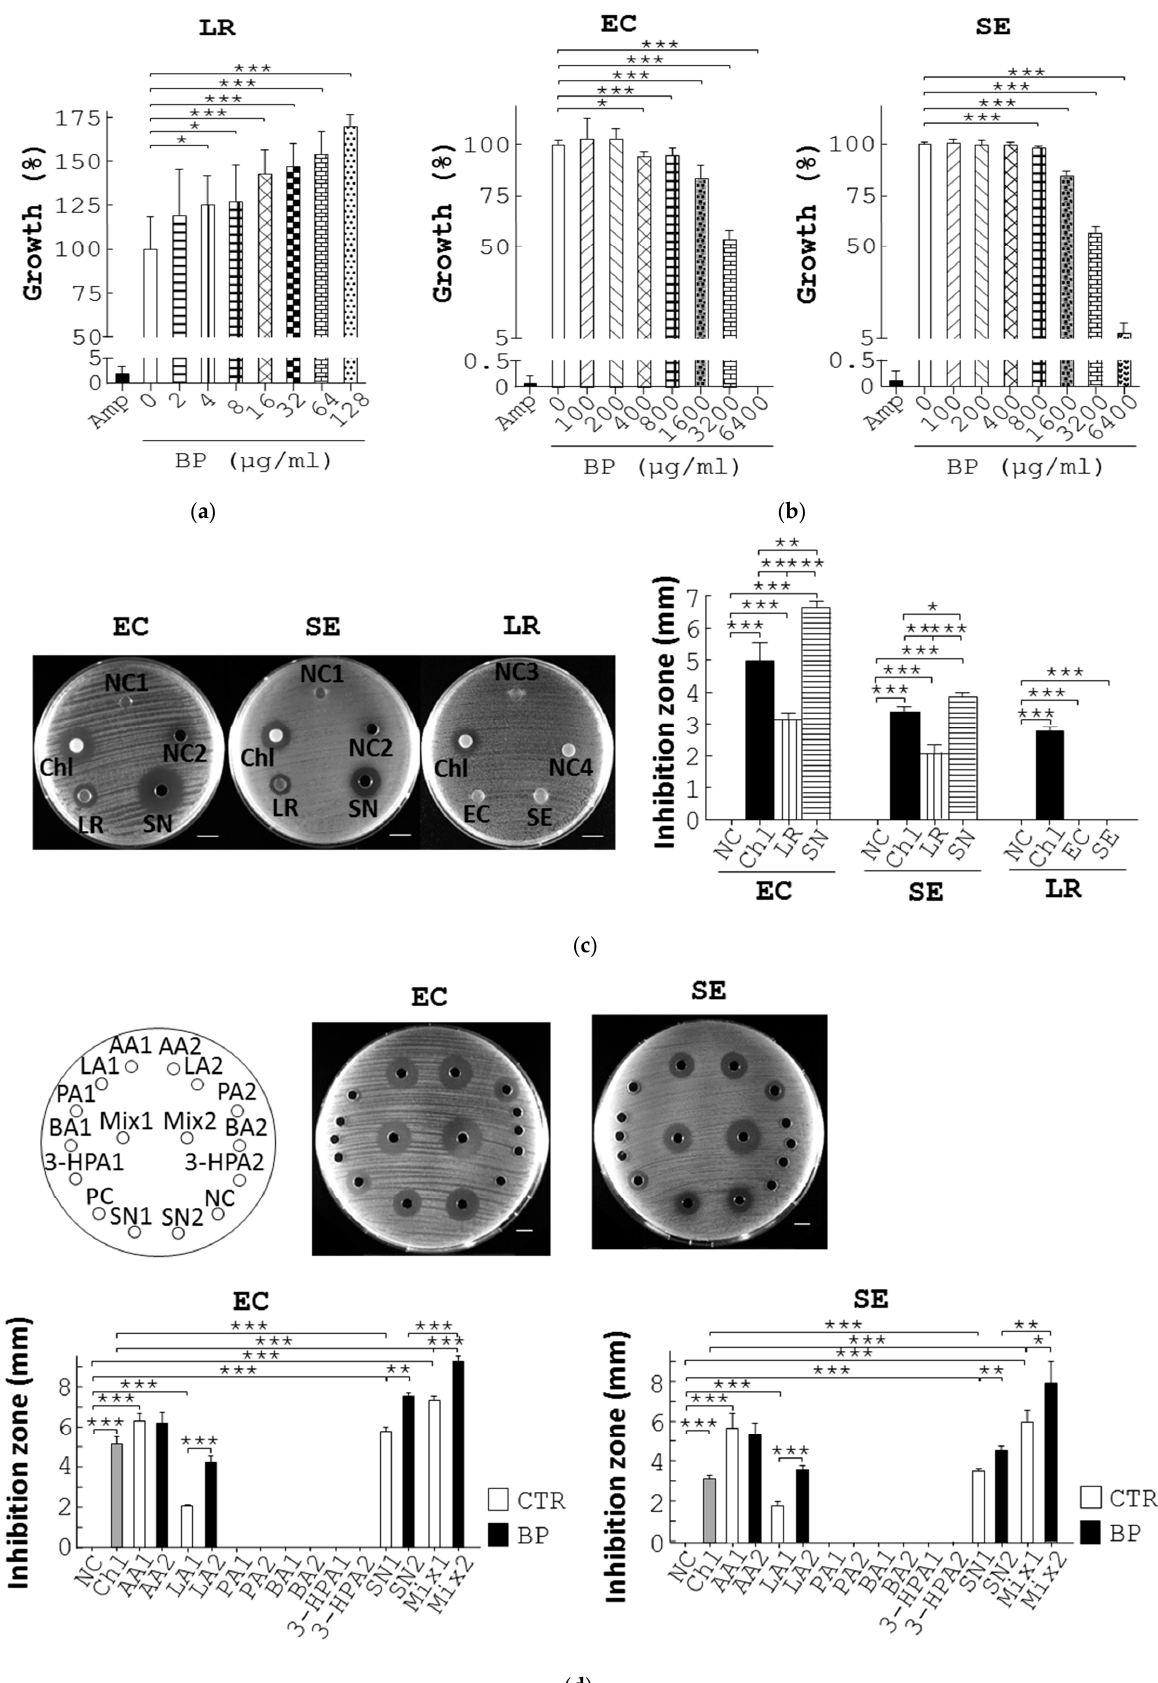
Figure 3. BP suppresses pathogenic growth via upregulation of L. reuteri growth and its antimicro- bial metabolites. ( a ) L. reuteri (LR) was cultured in MRS medium containing Amp, 0.1% methanol (0), and BP at the indicated dosages at 37 °C under anaerobic conditions for 10 h. The growth rate (%) of bacteria was obtained from the ratio of the OD 600 of the treatment group to that of the control group multiplied by 100%. ( b ) The same procedure as ( a ) was performed except that E. coli (EC) and S. enterica (SE) were grown in LB broth containing Amp, 0.1% methanol (0), and BP at the indicated dosages. ( c ) Antagonisms between L. reuteri and pathogens. E. coli (EC, 1st column, left) and S. en- terica (SE, 2nd column, left) were spread on LB plates and incubated with a MRS agar disc (NC1), 150 µL MRS medium (NC2), a paper disc containing 1 µg Chl, L. reuteri grown on an agar disc (LR), and 150 µL supernatant of L. reuteri (SN). L. reuteri (LR, 3rd column, left) was spread on MRS plates and incubated with a LB agar disc (NC3), 5 µL water (NC4), a paper disc containing Chl (1 µg), and E. coli (EC) and S. enterica (SE) grown on agar discs. Scale bar = 1 cm. The diameter (mm) of their inhibition zones was measured and replotted into histograms (right). ( d ) The labelling of the treat- ment groups in the plate is indicated (top left). E. coli (EC, top middle), and S. enterica (SE, top right) were spread on LB plates and incubated with 150 µL MRS broth (NC), Chl (1 µg), AA (462.3 µg, AA1), LA (222.97 µg, LA1), PA (0.29 µg, PA1), BA (0.56 µg, BA1), 3-HPA (1.80 µg, 3-HPA1), a mix- ture of AA1, LA1, PA1, BA1, and 3-HPA1 (mix1), the supernatant of L. reuteri culture (SN1), AA (440.13 µg, AA2), LA (715.33 µg, LA2), PA (0.23 µg, PA2), BA (0.7 µg, BA2), 3-HPA (5.3 µg, 3-HPA2), a mixture of AA2, LA2, PA2, BA2, 3-HPA2 (mix2), and the supernatant of L. reuteri cultured with BP (SN2) for 16 h. Scale bar = 1 cm. The diameter (mm) of their inhibition zones was measured and replotted into histograms (bottom). Data from 3 repeats are presented as the mean ± SD. One-way ANOVA tests were used for statistical analysis of differences between groups and p (*) < 0.05, p (**) < 0.01, and p (***) < 0.001 are considered statistically significant. 3.4. BP Inhibits Pathogenic Bacteria through Upregulation of SCFA in L. reuteri To decode the mechanism by which BP inhibited pathogens through the action of probiotics, we first tested the antagonism between L. reuteri and E. coli or S. enterica . Disc diffusion assays showed no inhibition on E. coli growth using discs containing MRS agar and MRS medium (NC1 and NC2, EC, Figure 3c). However, the positive control, chloram-